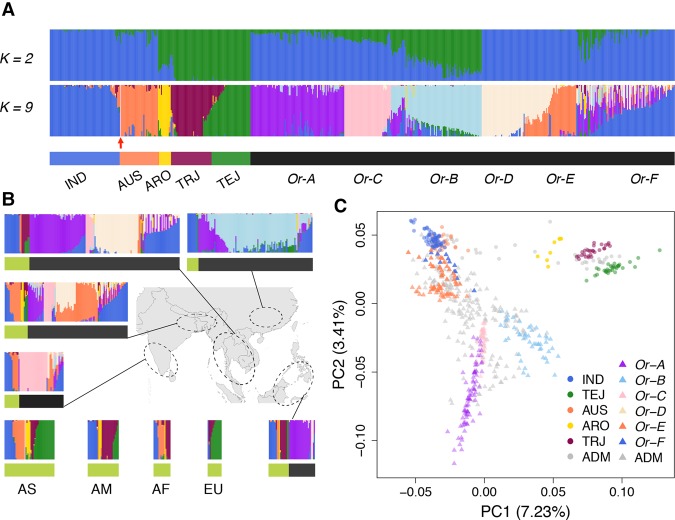
Population structure of the rice primary gene pool, including O. sativa and O. rufipogon. (A) Clustering using NGSadmix assuming K = 2 and K = 9. At K = 2, the samples are divided into indica and japonica components. At K = 9, five subgroups of domesticated rice are recovered, and four unique components of wild rice are identified. The color bars beneath the clusters denote the subgroup assignments. The red arrow points to the misidentified domesticated accession (GSOR311586), which was confirmed to have wild rice ancestry. The abbreviations of subgroups in cultivated rice are as follows: (ADM) admixture; (IND) indica; (AUS) aus; (ARO) aromatic; (TRJ) tropical japonica; (TEJ) temperate japonica. (B) Geographic distribution of rice samples. South and Southeast Asia, which are the major habitats for wild rice and also major rice cultivation areas, are shown on the map. The area was divided into five regions: (1) South Asia; (2) Ganges Basin; (3) Indochina Peninsula; (4) China; (5) Archipelago countries. The color code of the bar beneath the clustering plot indicates cultivated (green) and wild (black) rice. The abbreviations at the bottom left are as follows: (AS) Asia; all rice samples from Asia but not shown on the map are included in this category; (AM) America; (AF) Africa; (EU) Europe. (C) PCA of the combined population with wild (triangle) and cultivated (dot) rice samples. The abbreviation codes are the same as those in A.